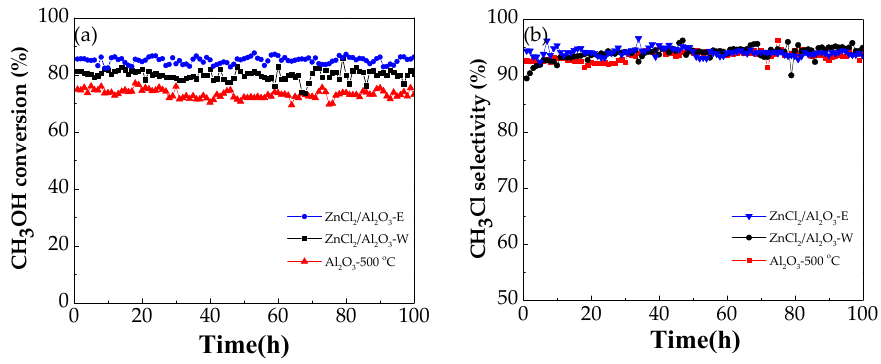
Figure 7. Lifetime test of the methanol conversion ( a ) and the methyl chloride selectivity ( b ) over neat and modified alumina (Conditions: 4.75 g MeOH ∙ g − 1 (cat.) ∙ h − 1 , temperature 280 °C).